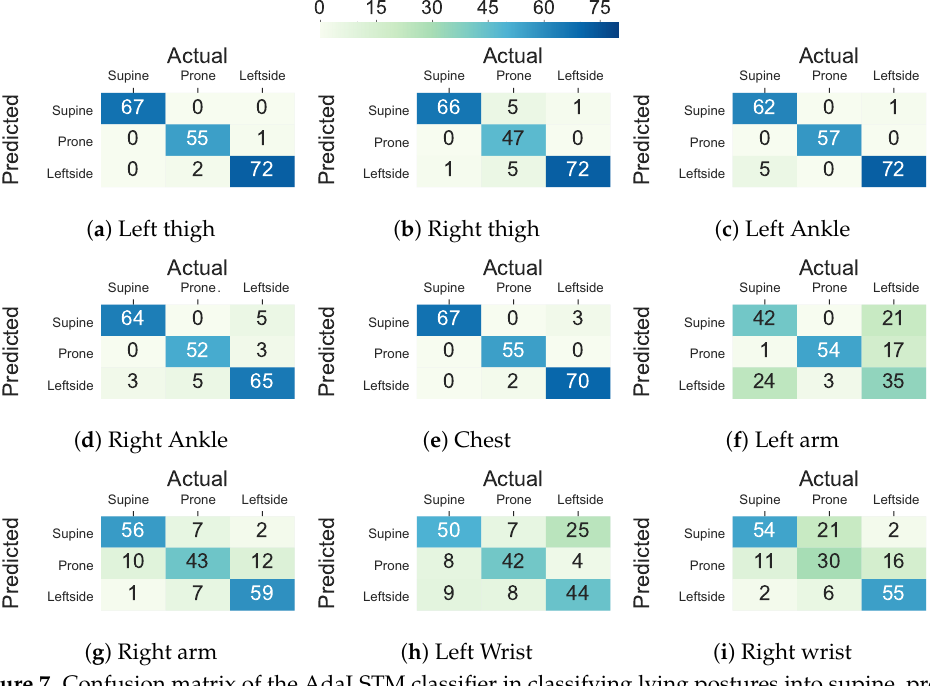
Figure 7. Confusion matrix of the AdaLSTM classifier in classifying lying postures into supine, prone, and left side for the thighs, ankles, chest, arms, and wrists locations using Class-Act